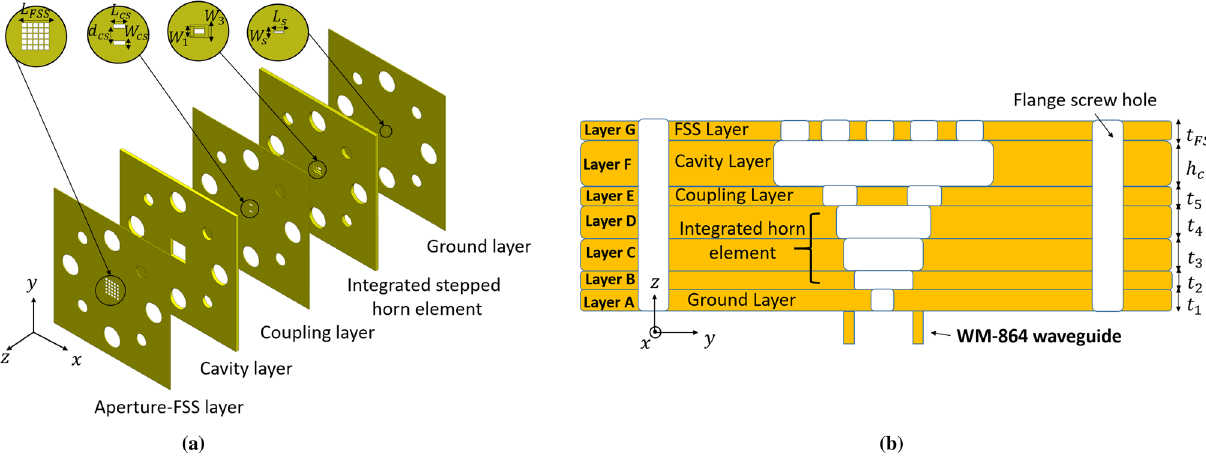
Figure 2. Configuration of the proposed 300 GHz FPC antenna with holes of standard WM-860 waveguide flange. ( a ) 3D-explosive structure ( b ) and sectional side-view.